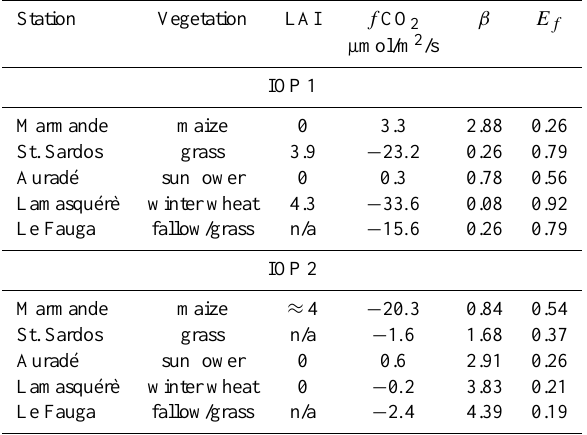
Table 5. Average data at ground sites between 11:50–14:00UTC (=LT − 2) during IOP1 (18–22 April) and IOP2 (7–14 September) at